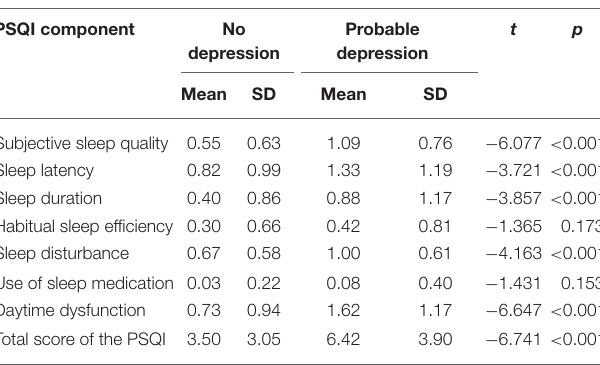
TABLE 4 | PSQI scores according to the